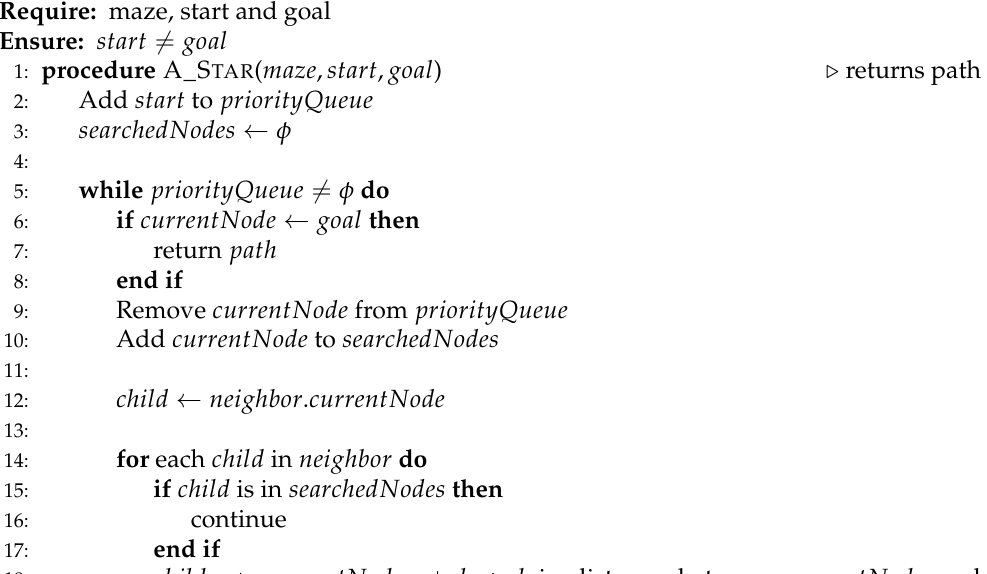
Algorithm 1 A* shortest path Algorithm with Greedy